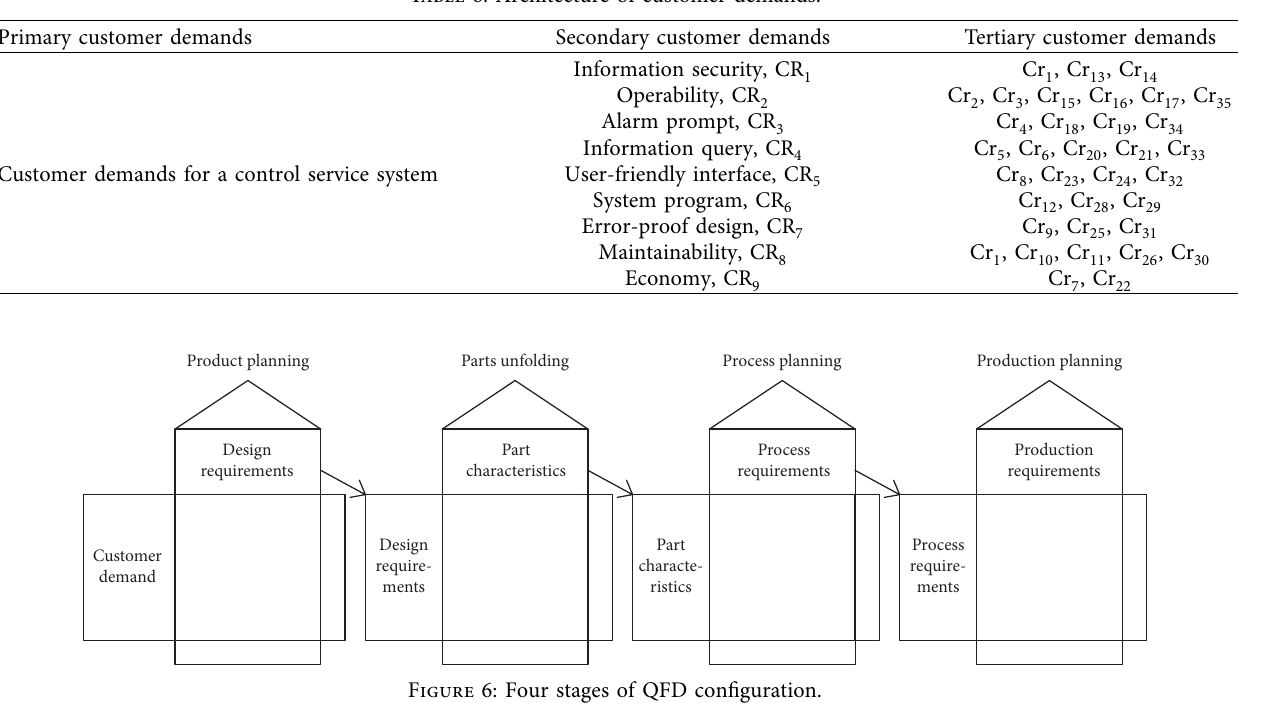
Figure 5: Clustering of customer demands. Table 6: Architecture of customer demands.